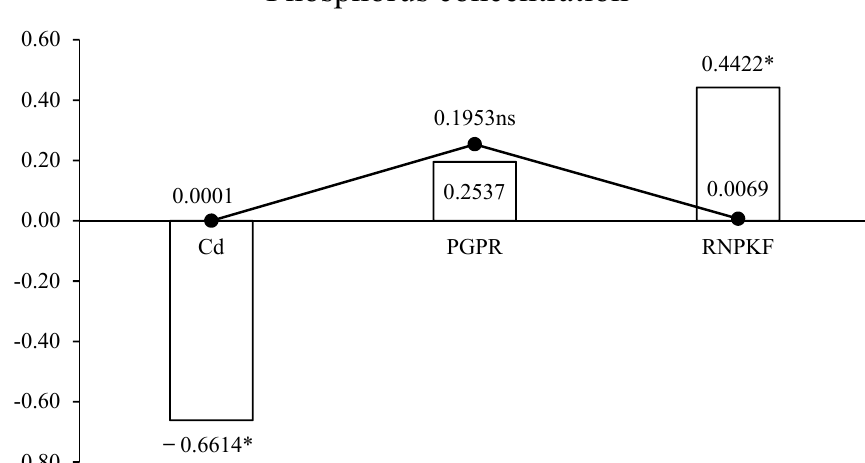
Figure 13. Pearson correlation of Cd, PGPRs, and RNPKF for bitter gourd phosphorus concentration (NB). * = significant ( p ≤ 0.05); ns = non ‐ significant.